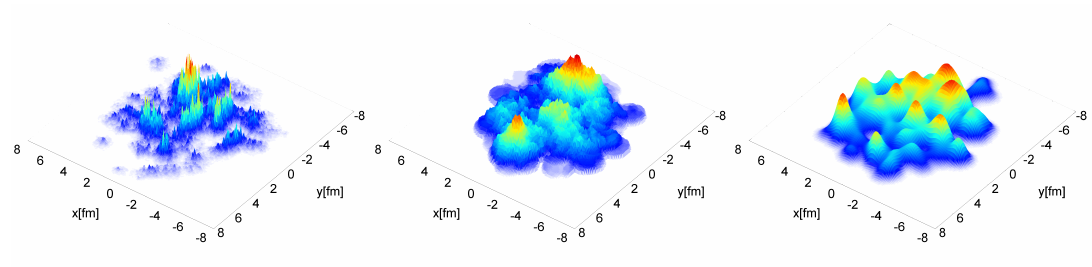
Figure 14. Examples of the initial energy density distribution from ( left ) the IP-Glasma model at τ = 0 fm, ( middle ) the MC-KLN model, and ( right ) the MC-Glauber model. Reproduced from Ref.